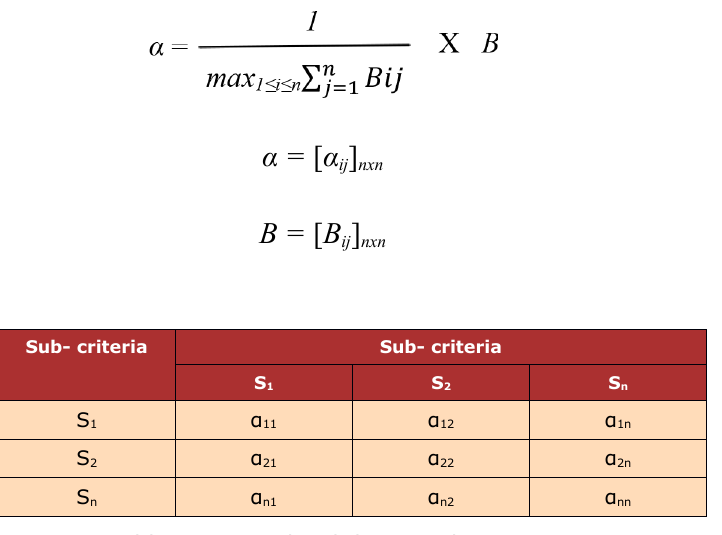
Table 4. Generalized direct- relation matrix